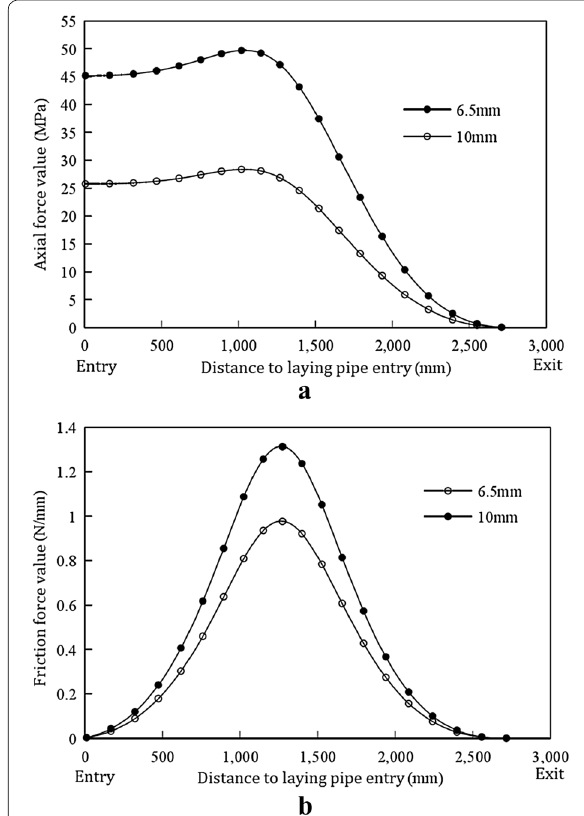
Figure 22 Numerical results with different wire rod dimension: a axial force in the design laying pipe; b friction force in the design laying